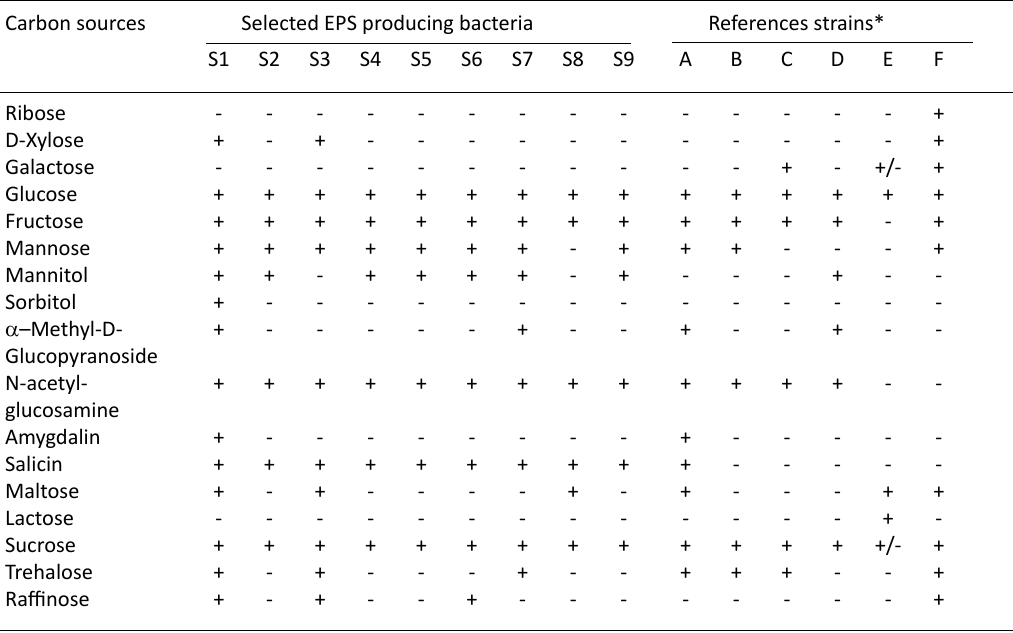
Table 4. Differential carbohydrate fermentation of the selected EPS isolates and related species Carbon sources Selected EPS producing